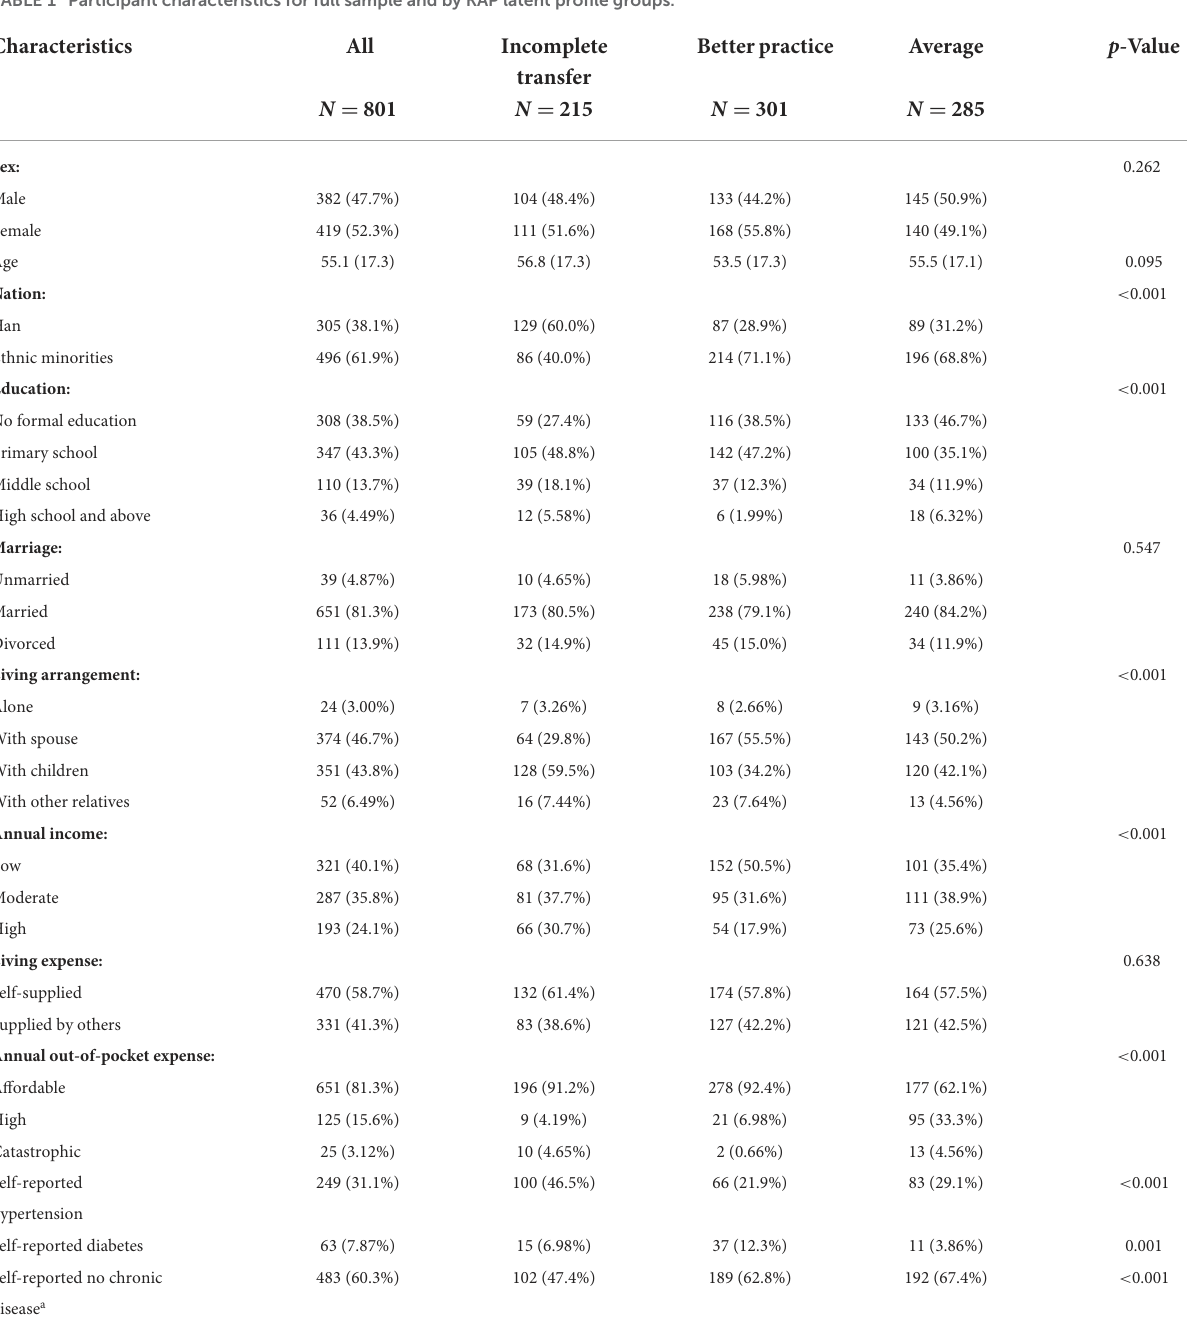
TABLE 1 Participant characteristics for full sample and by KAP latent profile